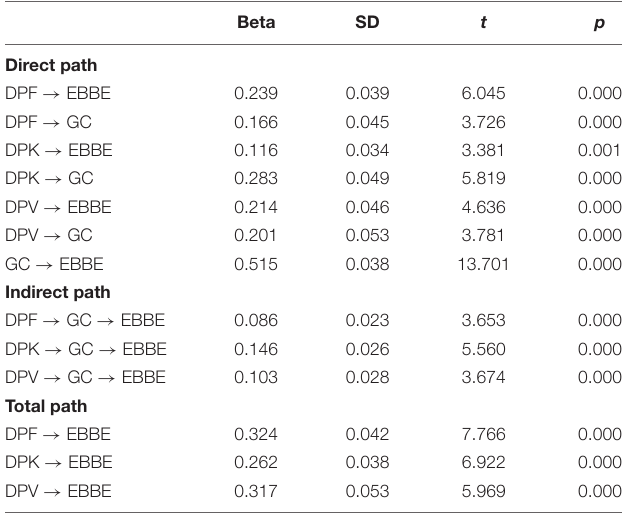
TABLE 2 | Discriminant validity (Fornell-Larcker-1981 criteria).